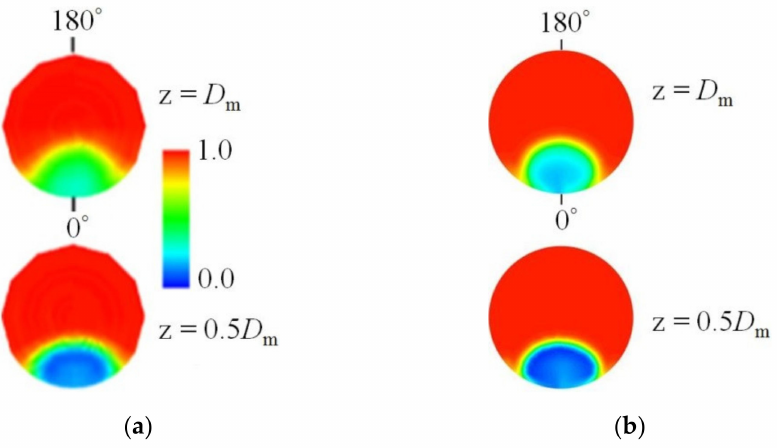
Figure 4. Distribution of the dimensionless temperature T* at Re m /Re b = 5.76: ( a ) LES [9]; ( b ) RANS.